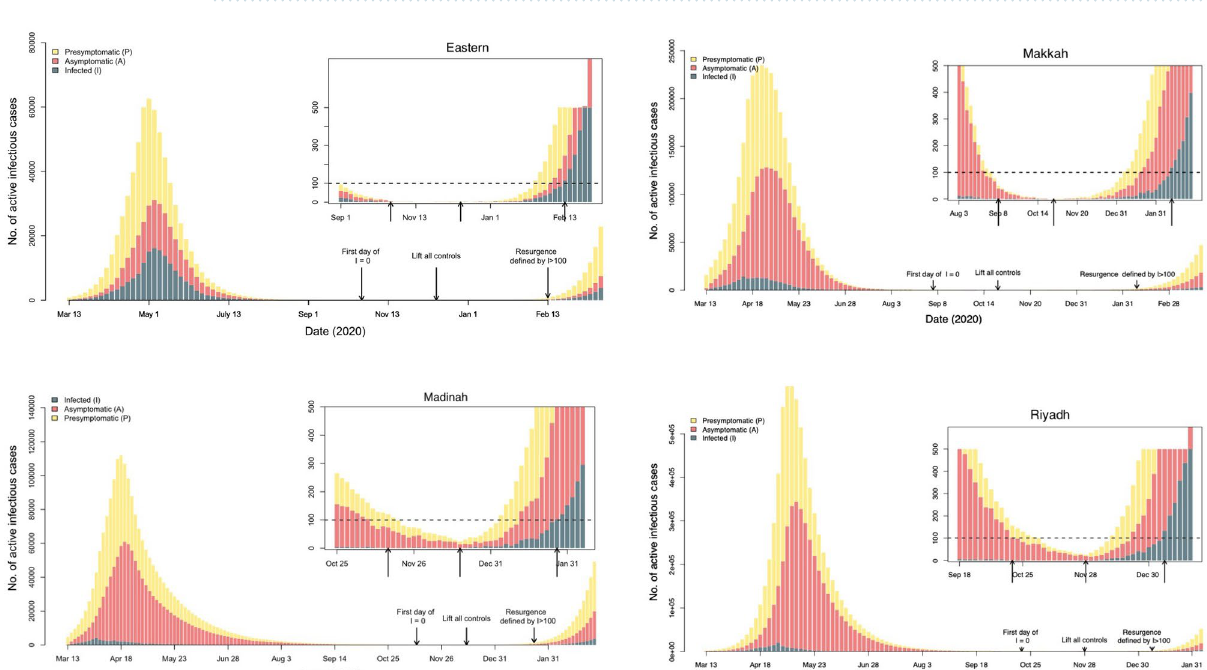
Figure 8. Figure demonstrating the effect of relaxing all control measures in all four regions 30 days following the first day without confirmed